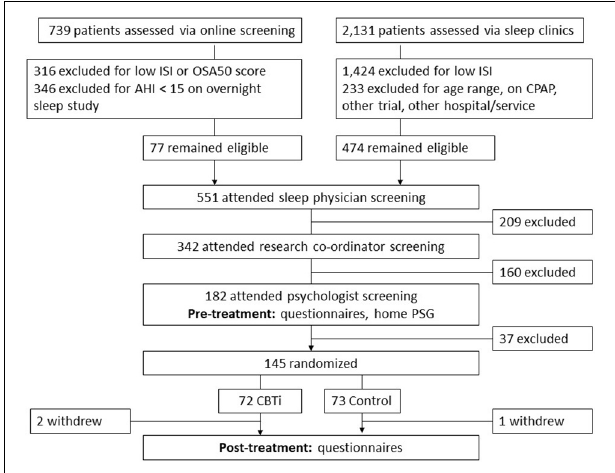
FIGURE 1 | Flow diagram indicating participant screening, randomization and follow-up. ISI, insomnia severity index; OSA50, obstructive sleep apnea 50 questionnaire; AHI, apnea–hypopnea index/h; and CPAP, continuous positive airway